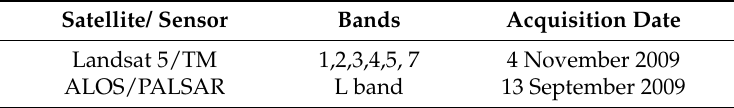
Table 2. Characteristics of the remote sensing